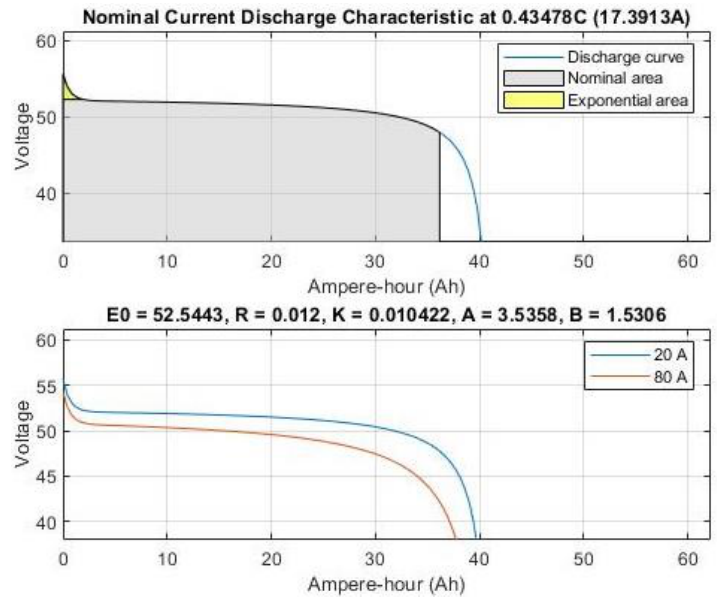
Figure 3. The discharge curve of the battery [39]. Table 3. Features of the battery used in the